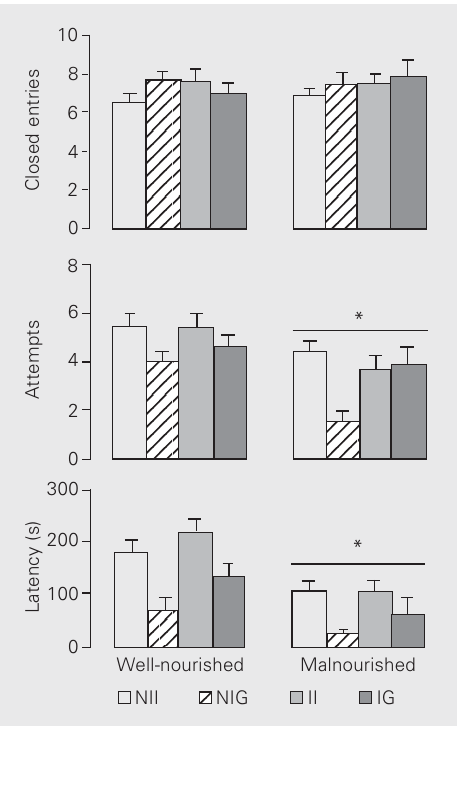
Figure 3. Number of rears (top), head-dips (middle) and stretch- attend postures (SAP, bottom) by non-immobilized animals reared individually (NII) or in groups (NIG) and immobilized animals reared individually (II) or in groups (IG). Data are reported as means ± SEM for 17-57 rats in each group. *P < 0.05 com- pared to IG in the same nutri- tional condition (Newman-Keuls test)